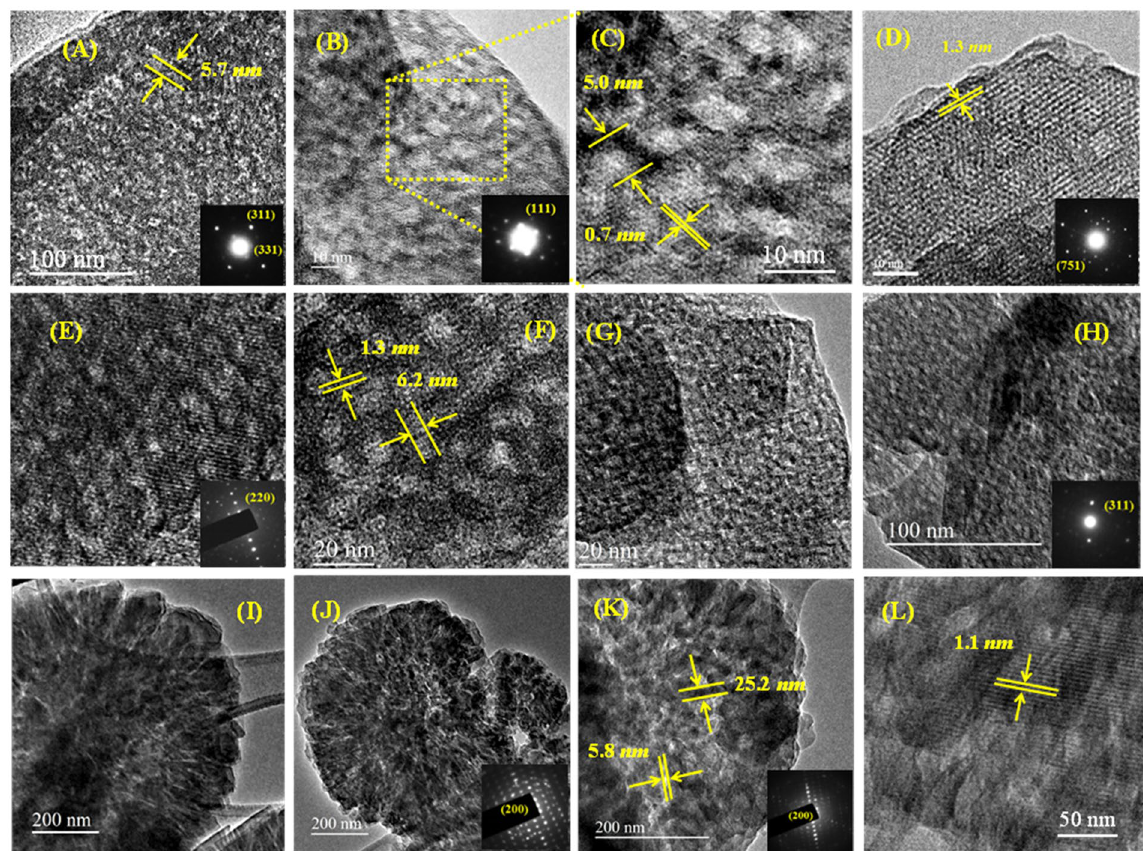
Figure 7. TEM micrographs and SAED patterns of ZH-Y ( A – D ), ZH-X ( E – H ) and ZH-A ( I – L ).